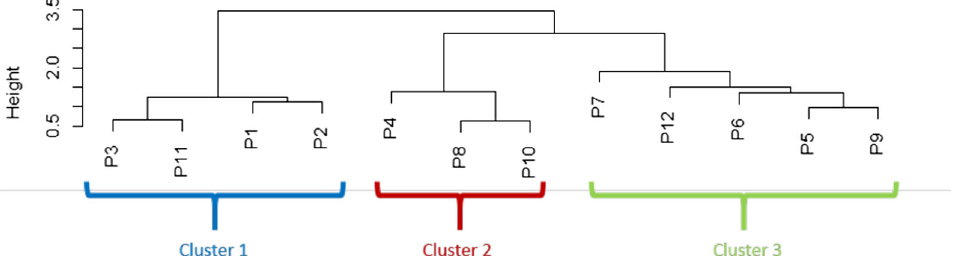
FIG. 7. Dendrogram of cluster analysis on expert ’ s ratings of problems. The height is a metric for measuring the relative distance between items and clusters. The three major clusters are largely independent of either the clustering algorithm or the choice of distance metric.